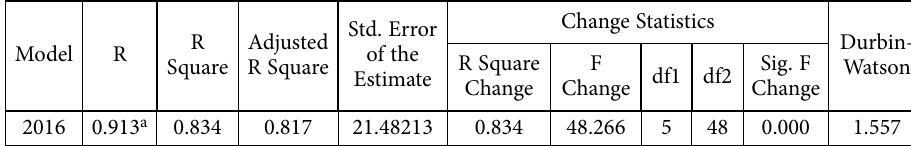
Table 5. Seasonal sustainability function for 2016